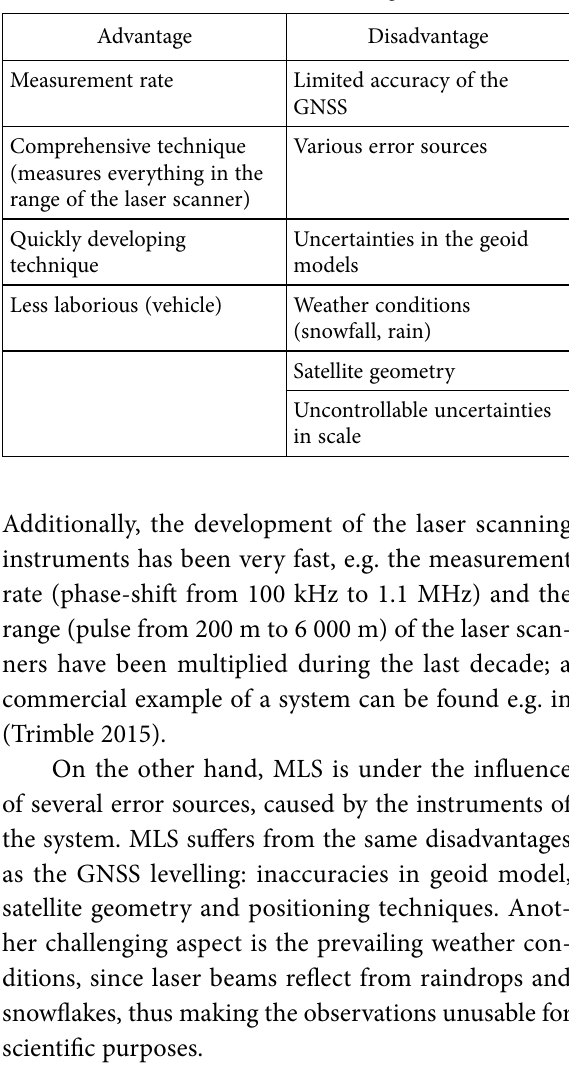
Table 4. Advantages and disadvantages related